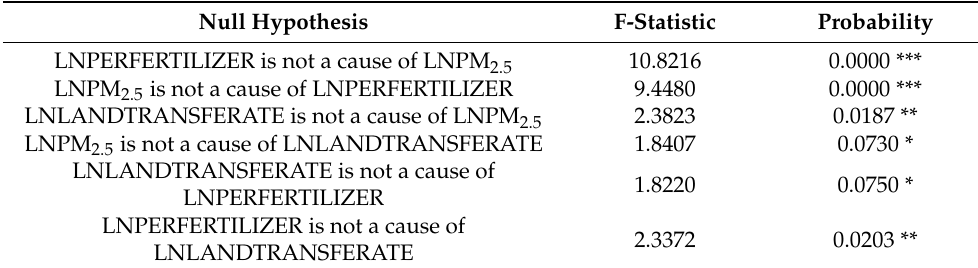
Table 6. Pairwise Granger Causality